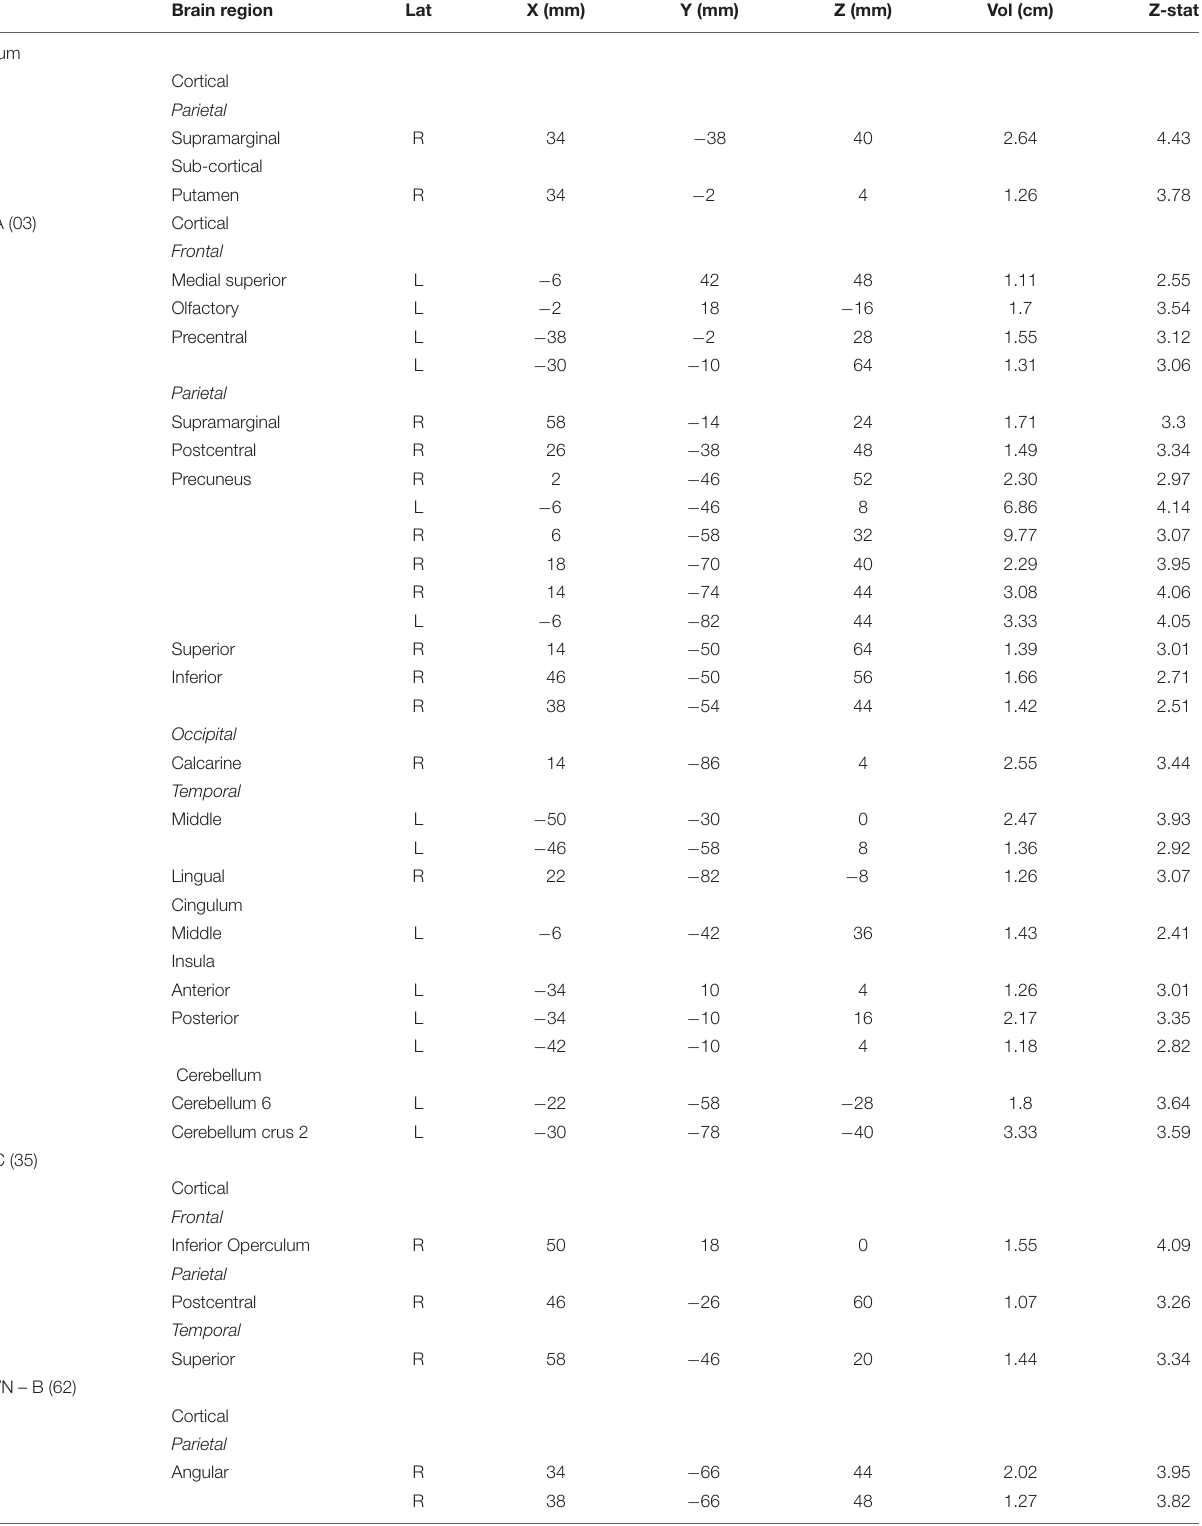
TABLE 6 | Interaction between groups – Adolescents (Mg > Hc) > Young adults (Mg > Hc). Brain region Lat X (mm) Y (mm) Z (mm) Vol (cm)